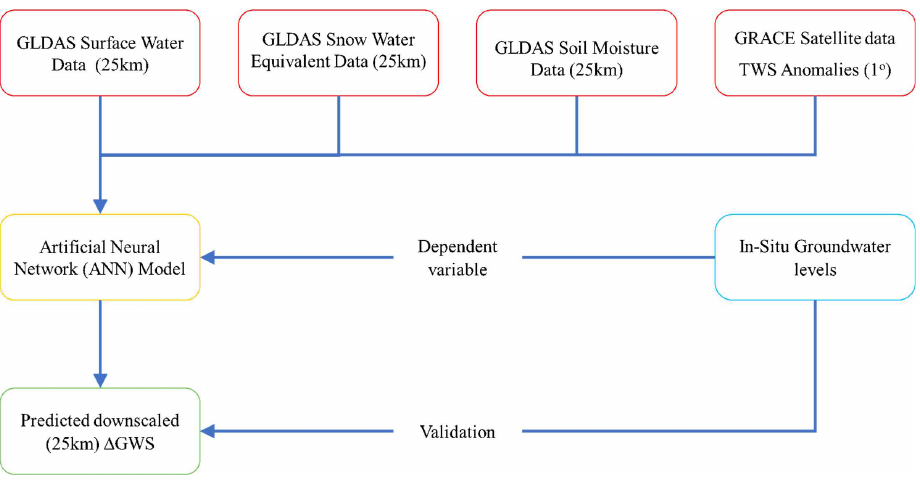
Figure 4. Predicted downscaled GRACE-GLDAS GWS changes with